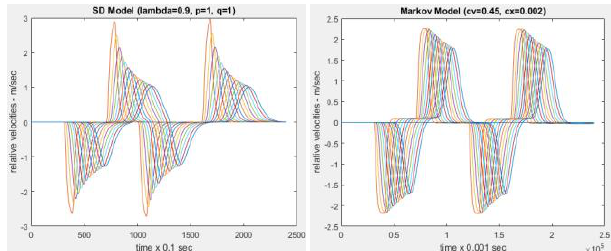
Fig. 4. The velocities of the followed drones.